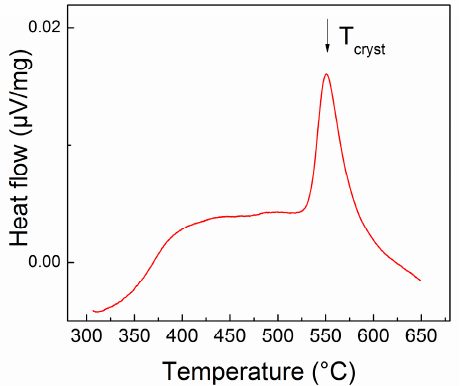
Figure 1. DSC curve plotted between 300 °C and 650 °C for the as-cast sample.